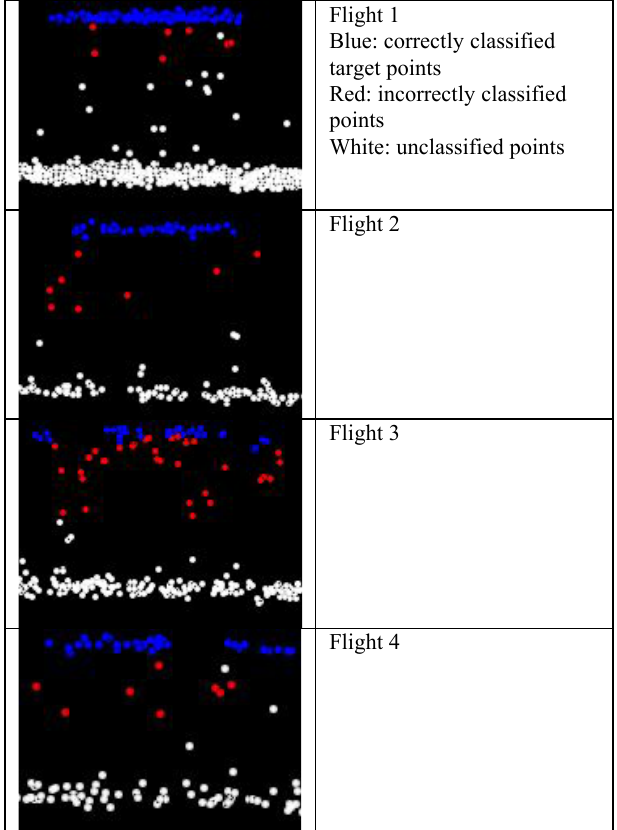
Figure 9. Point cloud for Target T6, blue and red points classified according to TerraScan’s “classify by intensity”